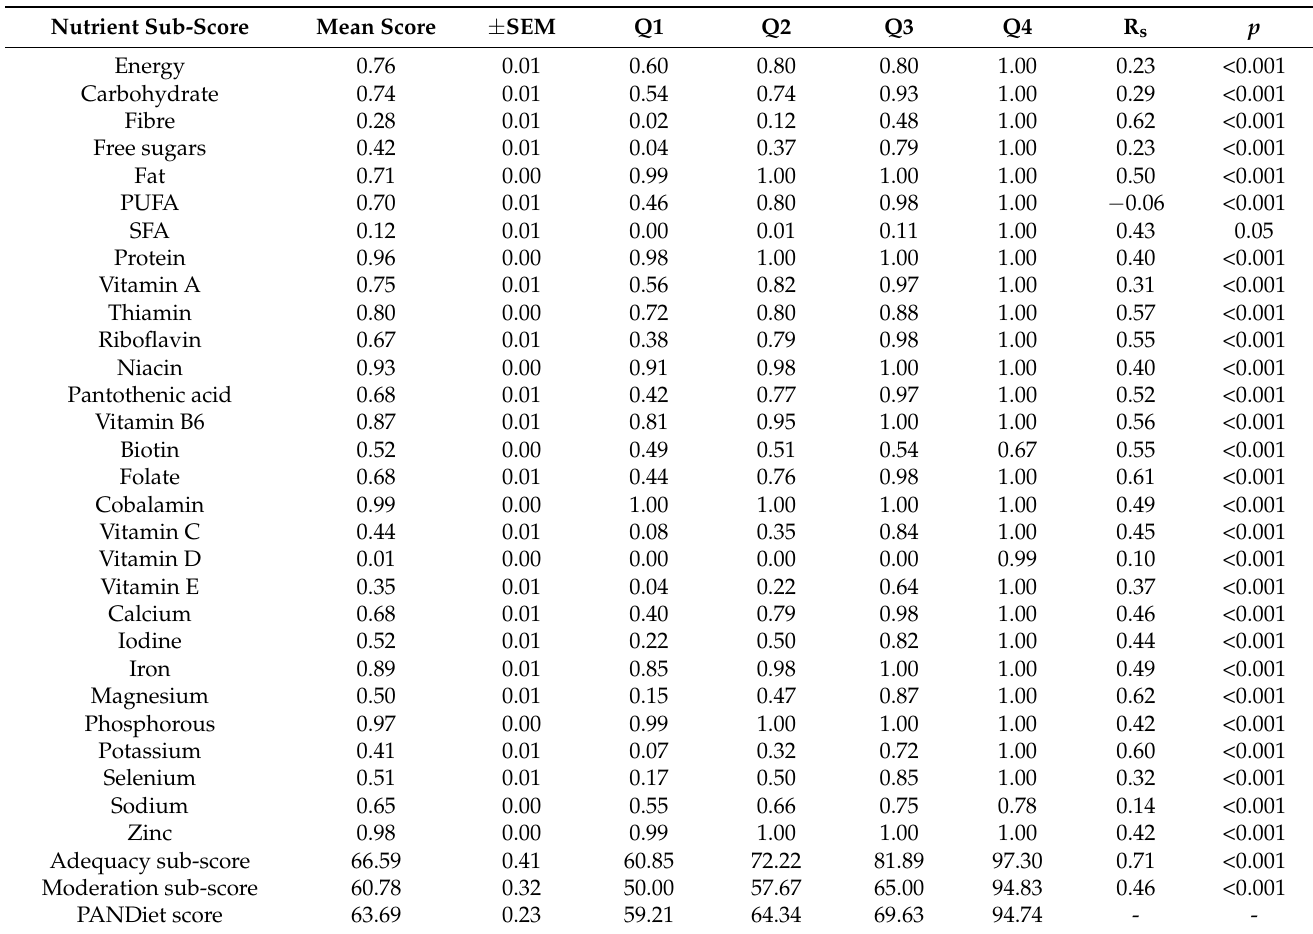
Table 1. Overview of nutrient sub-scores, and correlation with PANDiet score and nutrient sub-scores and food-based